Question: Express in one sentence what the figure is showing.
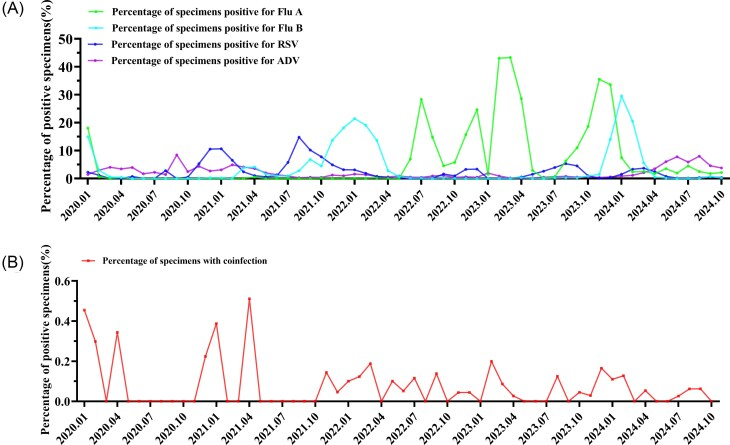
Answer: Epidemiological trends of four respiratory pathogens and coinfections from 2020 to 2024. (A) Temporal trends in the prevalence of four respiratory pathogens and coinfections from 2020 to 2024. (B) Temporal trends in the prevalence of coinfections from 2020 to 2024.